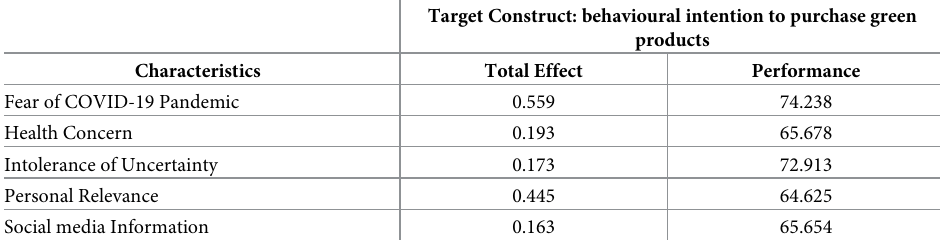
Table 6. Performance and total